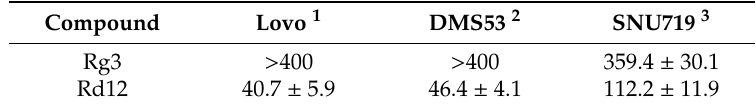
Table 2. In vitro cytotoxicity of ginsenoside Rd12 ( µ